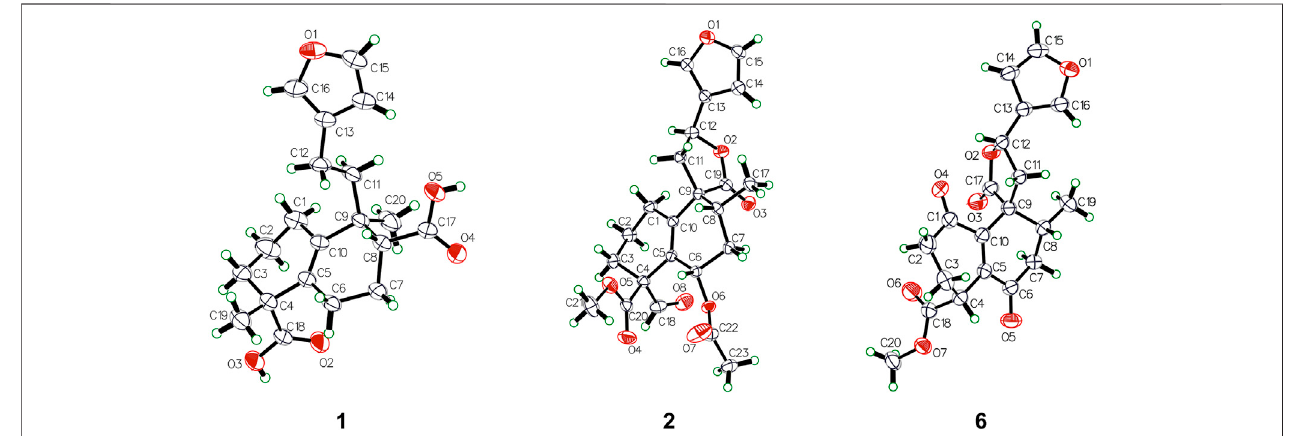
FIGURE 1 | Key 1 H – 1 H COSY and HMBC correlations of compounds 1 – 7 .